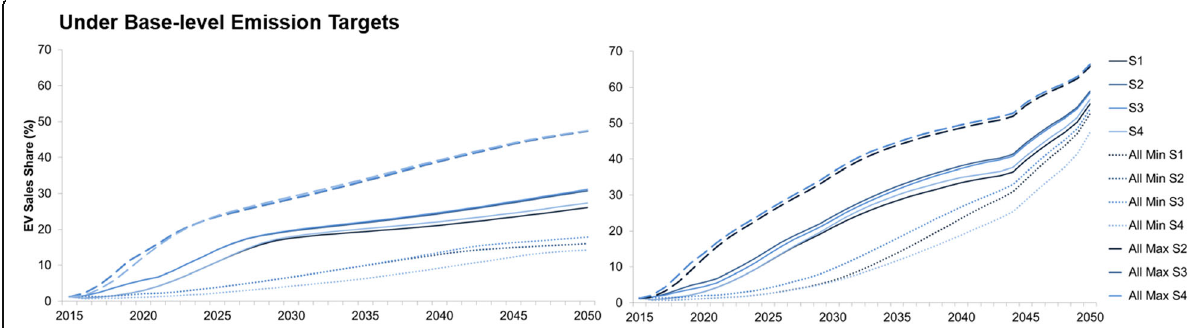
Fig. 7 EV sales shares under Base and Mid-level emission targets, extreme variables and various subsidy